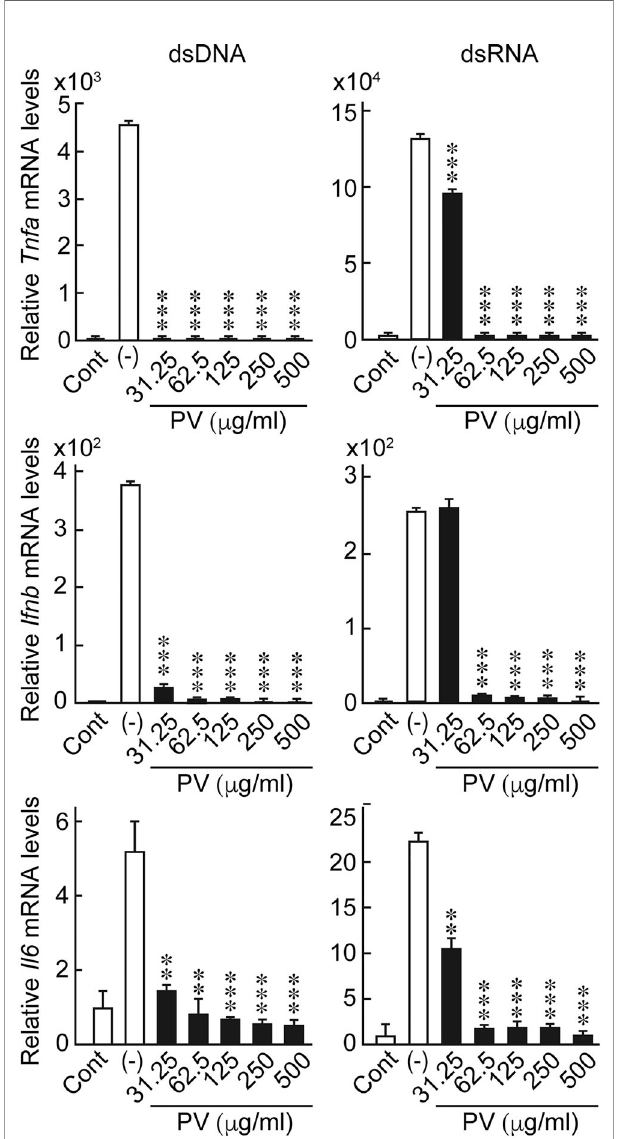
FIGURE 1 | PV suppresses the mRNA expression of in fl ammatory cytokines induced by dsDNA or dsRNA. FRTL-5 cells were pretreated with PV at increasing concentrations (0, 31.25, 62.5, 125, 250, 500 m g/mL) for 24 h. Cells were then stimulated with 1 m g of dsDNA or dsRNA for 24 h in the presence of absence of PV. Total RNA was puri fi ed and subjected to real- time PCR analysis to determine the relative mRNA expression levels of Tnfa, Ifnb and Il6. mRNA levels were normalized against Gapdh levels and expressed as fold-change relative to the control. Data are presented as mean ± SD (n = 3) relative to the mRNA levels of non-treated control cells. ** p < 0.01 and *** p < 0.001, compared to the PV ( − ) value.